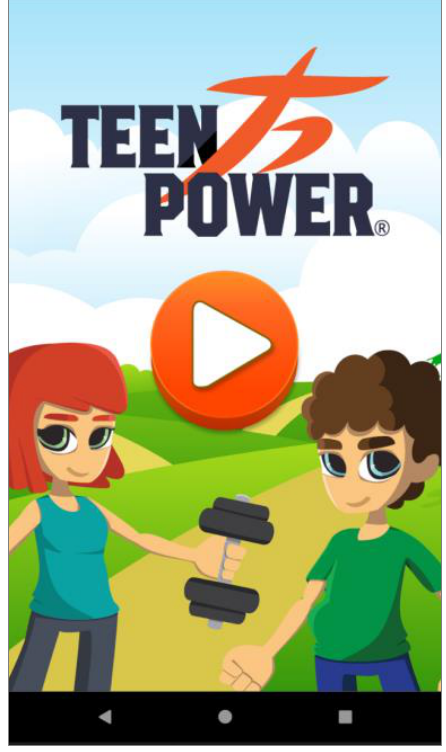
Figure 2. Home screen—affordance; interaction.